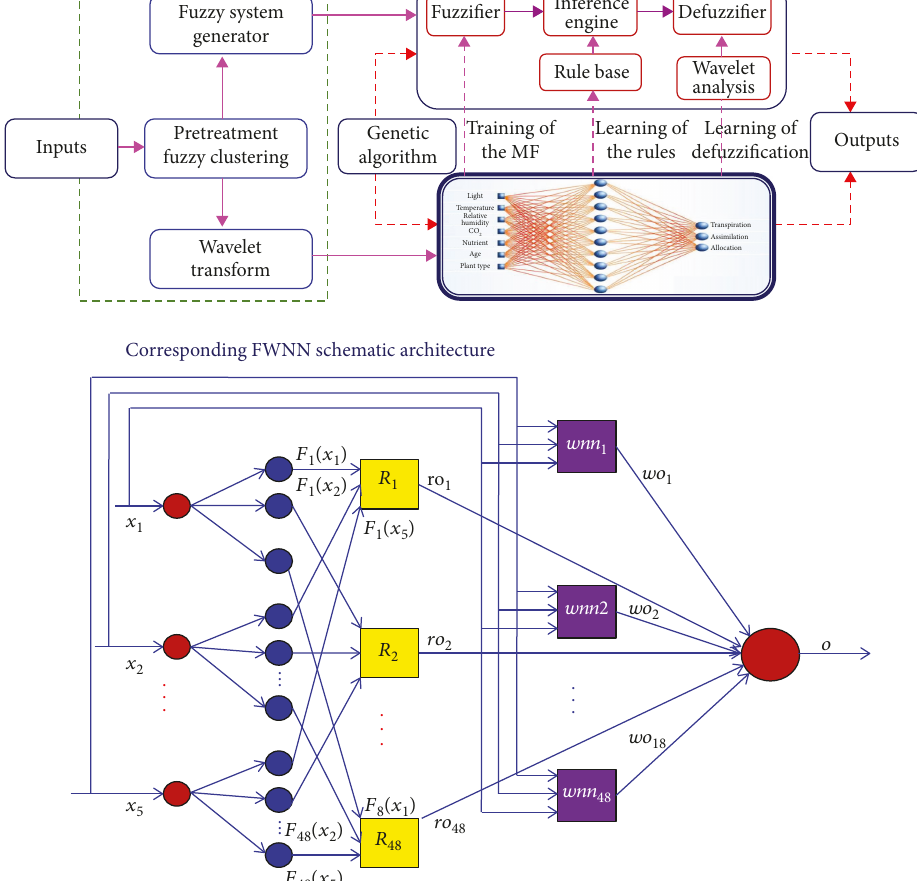
Figure 2: Schematic structure of FWNN